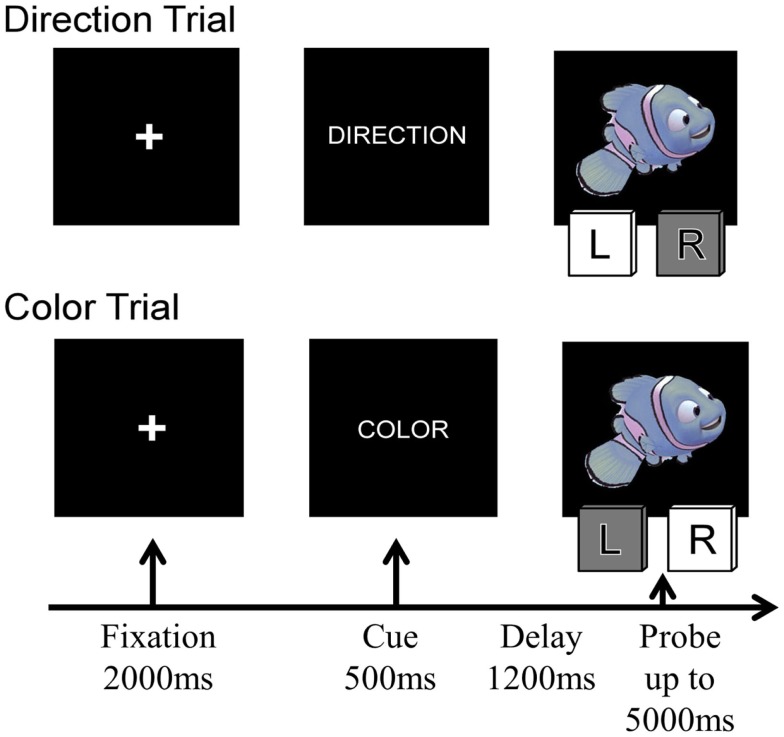
Four sample trials of the Nemo task, showing the sequence of stimuli presented on each trial. The condition labels and the indicated correct responses correspond to the rule “Blue is left, red is right.”